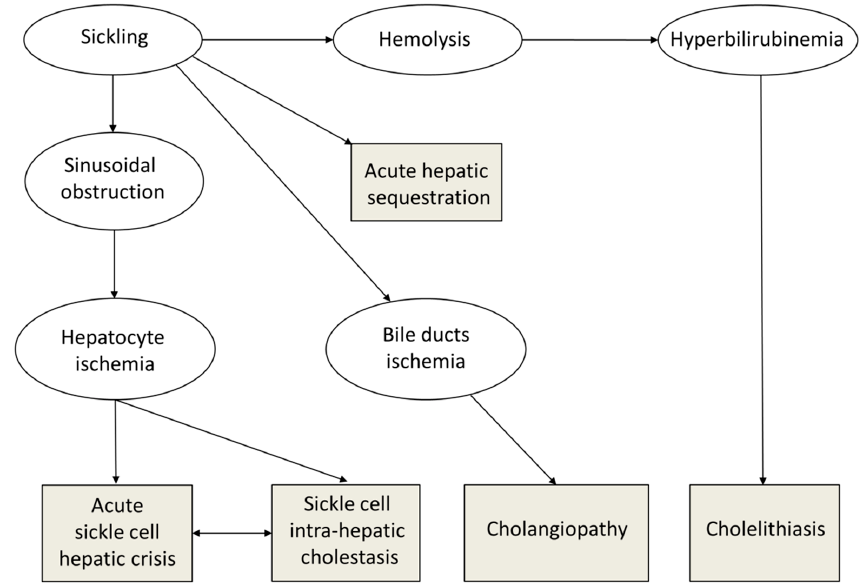
Figure 1. Pathophysiology of hepatobiliary complications in sickle cell disease (SCD). Sinusoidal obstruction by sickled red blood cells results in hepatocyte ischemia, with secondary ballooning of adjacent hepatocytes and intracanalicular cholestasis. Vascular obstruction may also cause red cell and platelet trapping in the liver, leading to acute hepatic sequestration. Depending on the relative degrees of ischemia, cholestasis, and cell trapping, the crises may present as acute sickle cell hepatic crisis, sickle cell intra-hepatic cholestasis, or hepatic sequestration. Bile ducts ischemia secondary to sickling is responsible for cholangiopathy, and chronic hemolysis is responsible for hyperbilirubinemia, promoting cholelithiasis